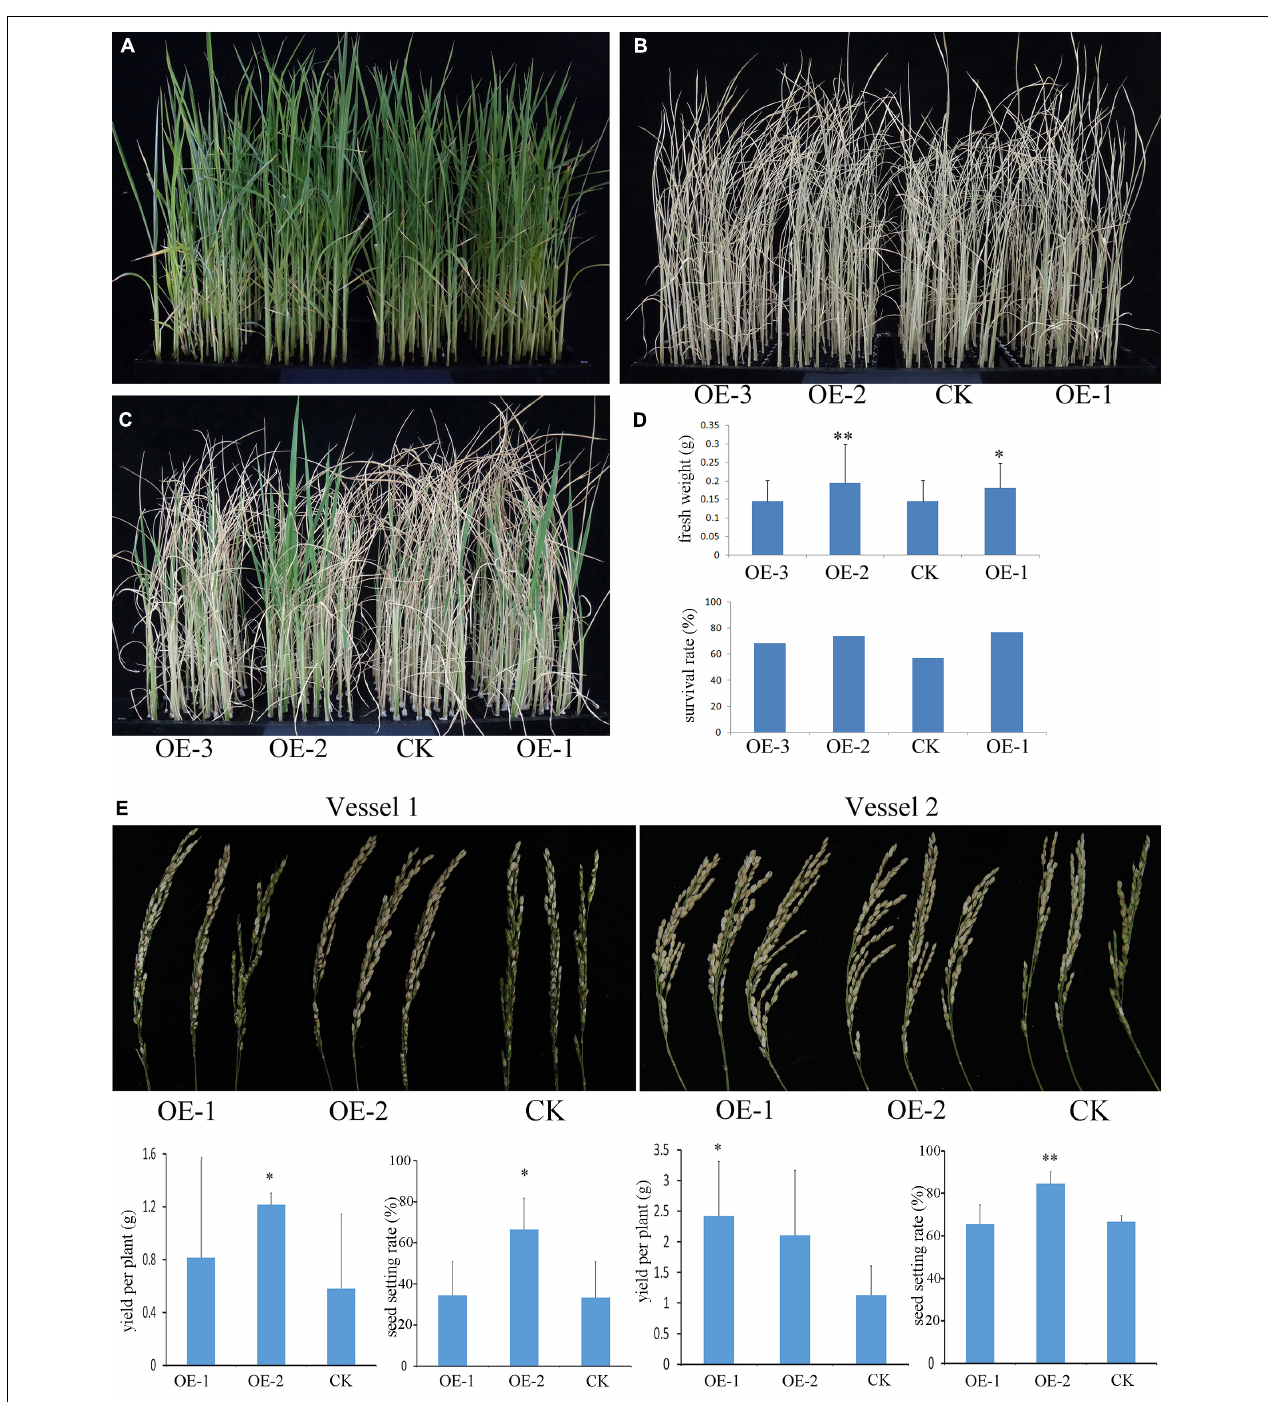
FIGURE 3 | Ectopic expression of PpBURP2 enhanced the tolerance of rice to drought stress. (A–D) Osmotic stress at the seedling stage. PpBURP2 transgenic rice plants and wild-type (WT) plants were cultured in 96-well plates and treated with 18% PEG6000 for 7 days. Representative images of the WT and transgenic seedlings before (A) , during (B) , and after which they recovered for 4 days (C) . (D) Fresh weight and survival rate of PpBURP2 transgenic plants and WT plants after PEG-simulated osmotic stress. (E) Drought stress at the adult stage. The transgenic plants and WT plants were grown in the same vessels with two repeats in Vessel 1 and Vessel 2 under normal conditions, respectively. At the booting stage, the water supply was withheld to cause drought stress. The upper of the images showed the panicles harvested after drought stress in Vessel 1 and Vessel 2. The yield per plant and seed setting rate in Vessel 1 and Vessel 2 were in the bottom. OE-1 and OE-2 indicate PpBURP2 transgenic line 1 and 2. CK indicates the WT plants. The error bars indicate standard errors (SEs) based on three replicates. ∗ p < 0.05 and ∗∗ p < 0.01.